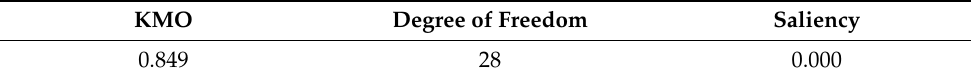
Table 3. KMO and Bartlett test results.